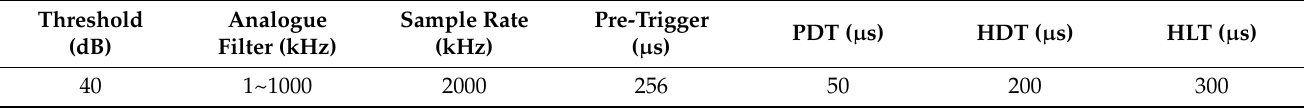
Figure 2. Deployment of AE sensors. The tunnel is divided into two parts (segment 1 tunnel and segment 2 tunnel), with channel connector as the boundary. ( a ) Locations of four tunnel sections for AE sensor deployment in tunnel inner lining; 6 AE sensors are mounted in each of segment 1 and segment 2 tunnel, and a total of 12 AE sensors are mounted on the surface of lining inner layer. ( b ) Locations of AE sensors on Sections 1–4. Table 2. Acquisition parameter settings of AE